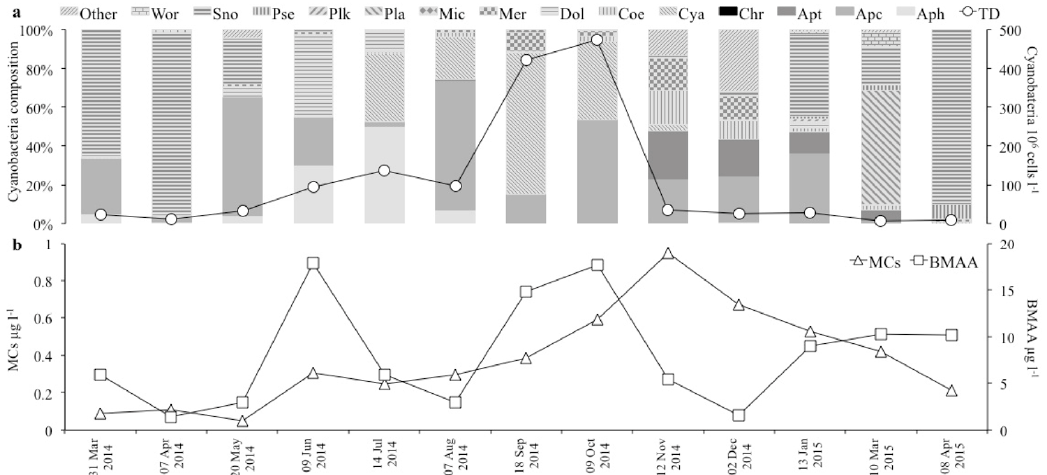
Figure 7. Temporal dynamics of ( a ) cyanobacteria composition at the genus level (left axis) and cell density (right axis) and of ( b ) microcystins (left axis) and BMAA (right axis) concentrations. (TD = cyanobacterial total cell density; Aph = Aphanizomenon ; Apc = Aphanocapsa ; Apt = Aphanothece ; Chr = Chroococcus ; Cya = Cyanocatena ; Coe = Coelosphaerium ; Dol = Dolichospermum ; Mer = Merismopedia ; Mic = Microcystis ; Pla = Planktolyngbya ; Plk = Planktothrix ; Pse = Pseudanabaena ; Sno = Snowella ; Wor = Woronichinia ; Other = unidentified cyanobacteria; BMAA = β - N -methylamino- L -alanine; MCs = microcystins).